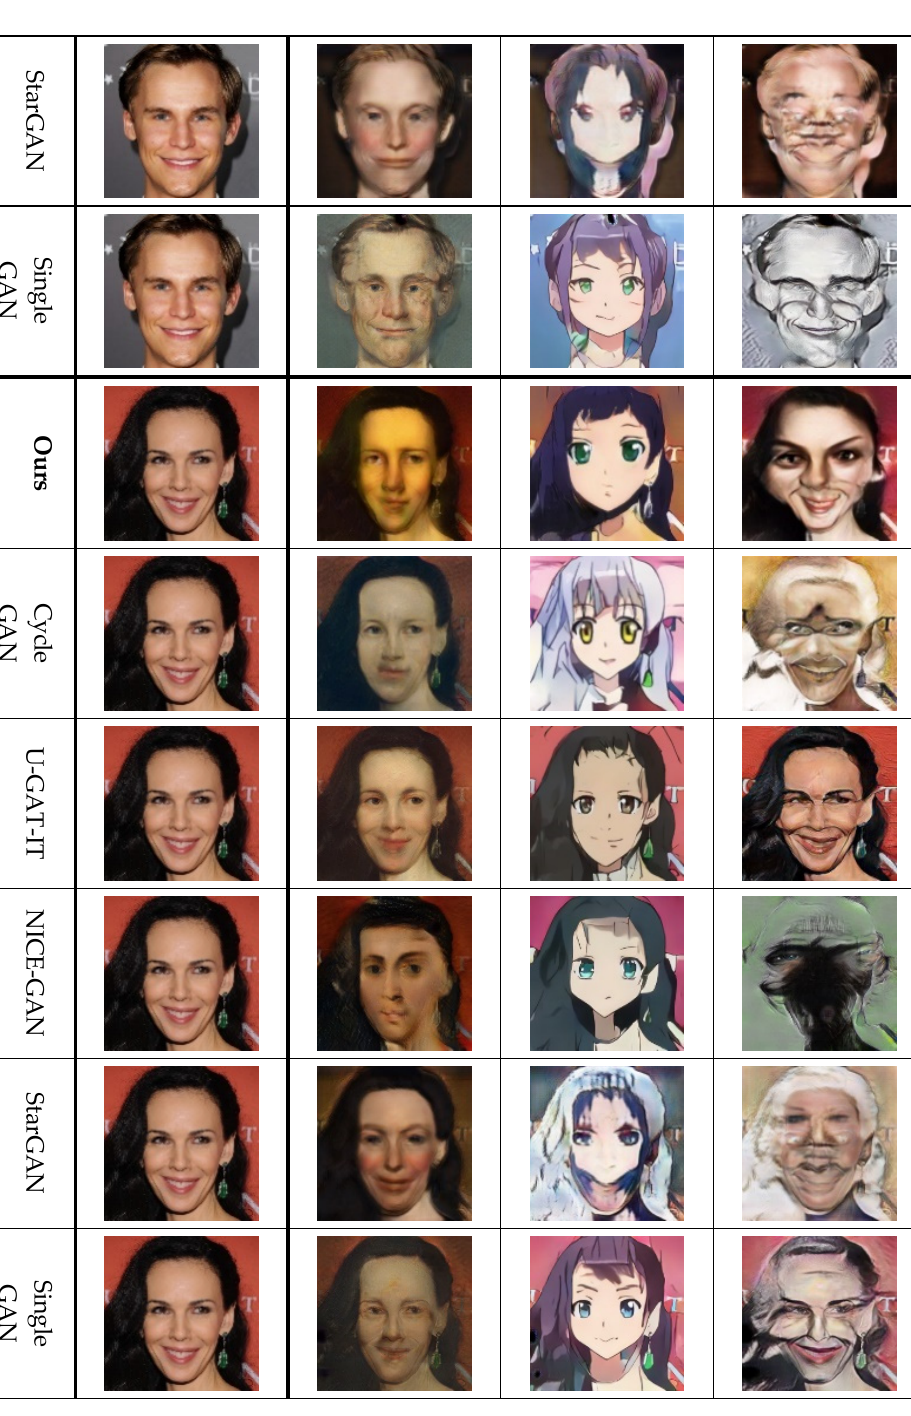
Figure 5. Comparing conditional artistic face translation results among translation models.